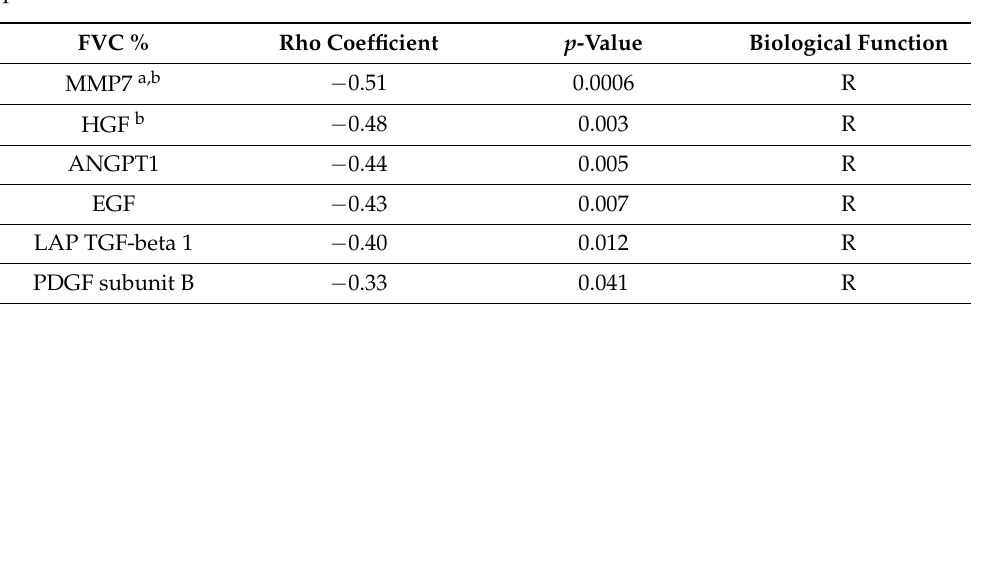
Table 5. Protein levels in IPF serum correlated to disease severity. Correlations between protein levels in serum from IPF patients and disease severity, defined by forced vital capacity (FVC, % predicted), total lung capacity (TLC, % predicted), diffusion capacity for carbon monoxide (DLCO, % predicted) and composite physiological index (CPI). Proteins are categorized in two main biological functions, tissue remodeling (R) and inflammation/chemotaxis (I). Three proteins have overlapping functions (O). Proteins significantly elevated in IPF compared to controls are indicated with b . Proteins observed in ex vivo model are indicated with a . p and r values were determined using Spearman rank correlation